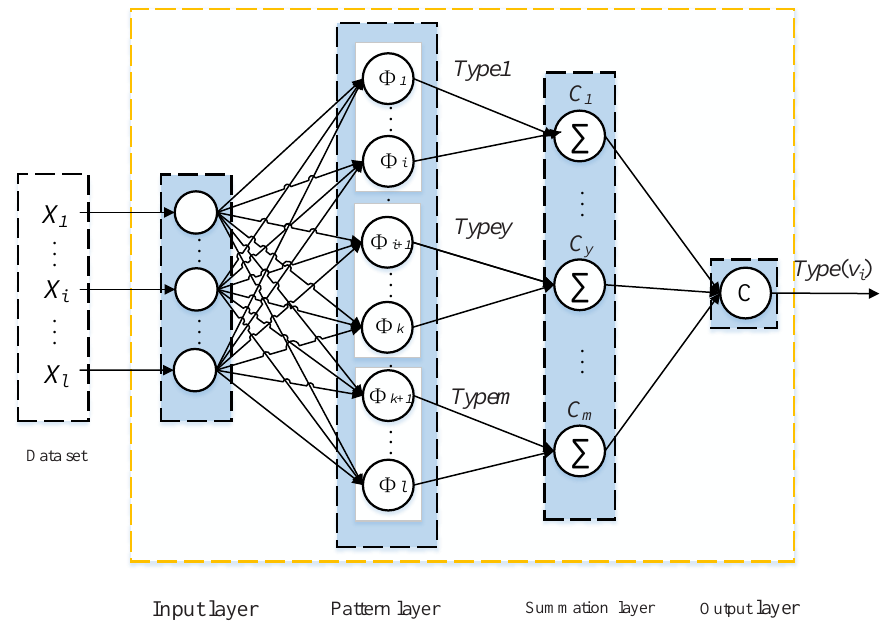
Figure 1. Probabilistic neural network (PNN)